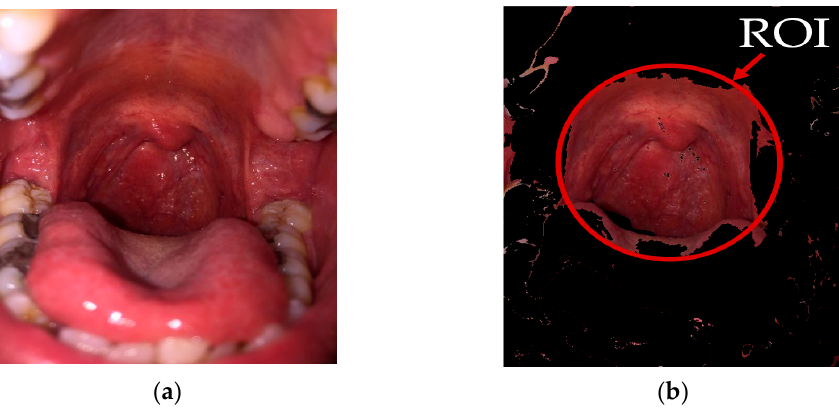
Figure 7. The example output obtained by the image segmentation step of our proposed method. ( a ) Original image, and ( b ) the ROI extracted from the original image in ( a ).